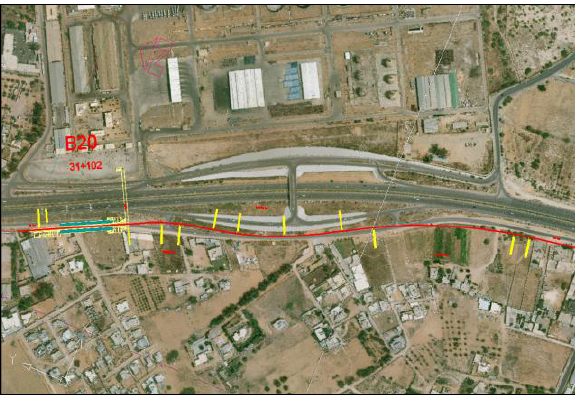
Figure 10. Metro line aligned avoiding bridge foundations